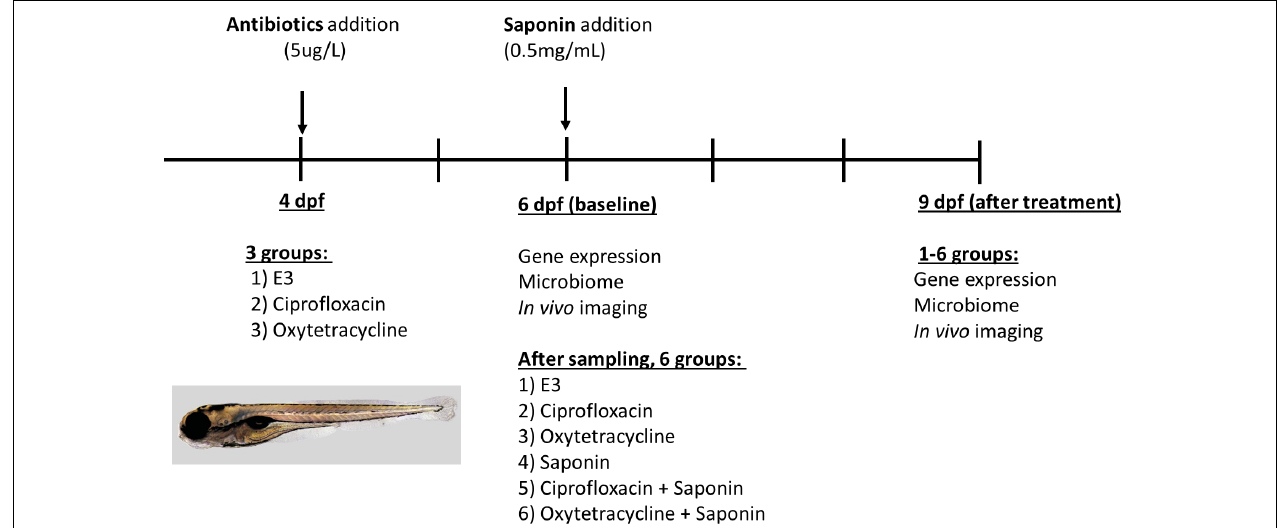
FIGURE 1 | Experimental design and sampling strategy for the antibiotics/saponin